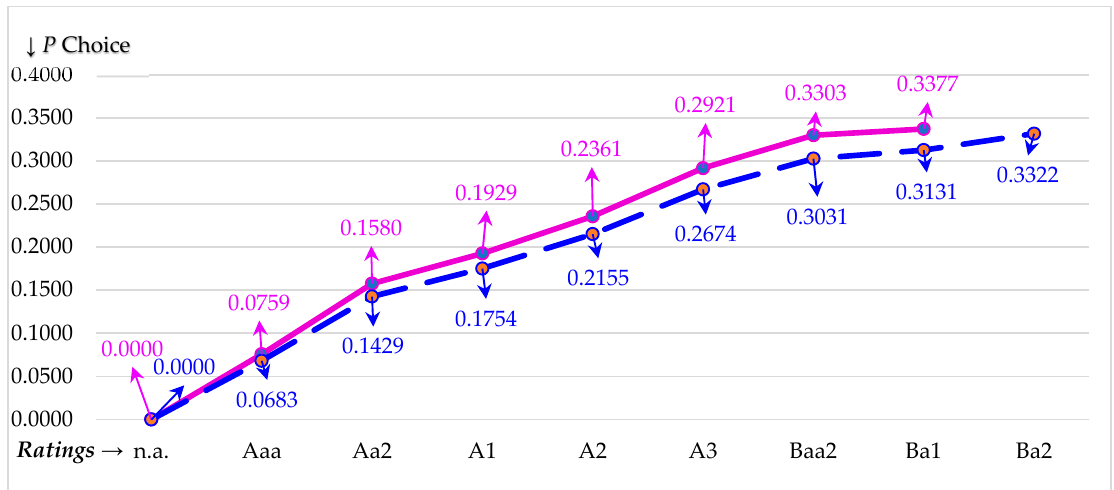
Figure 1. P choices are plotted along vertical axis against Moody’s credit ratings along horizontal axis. P is debt divided by unlevered equity value. The nonprofit trajectory is the solid line and the pass-through trajectory is the dashed line. We use credit spreads for 2019, TCJA low ( L ) tax rates, and 3.12% growth where the growth ( RE ) constraint sets in after Ba1 for nonprofits (NPs) and after Ba2 for pass-throughs (PTs). The optimal credit rating ( OCR ) is A3.